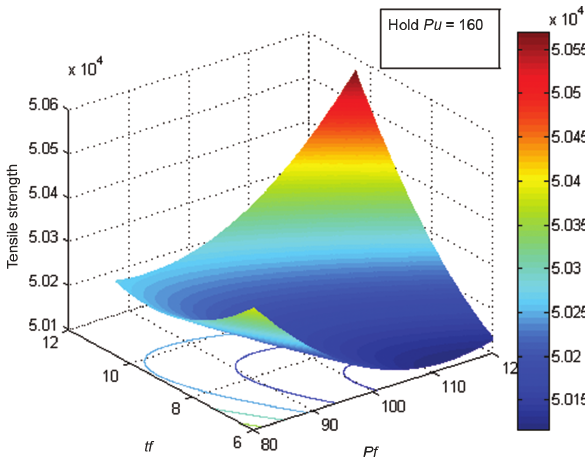
Figure 7: Surface plot of tensile strength versus tf and Pf .